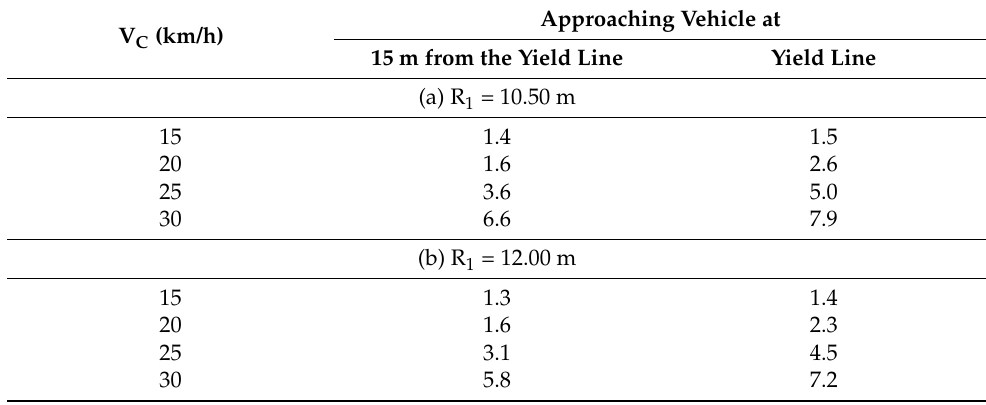
Table 3. Maximum lateral clearance for conflicting-circulating vehicle (in